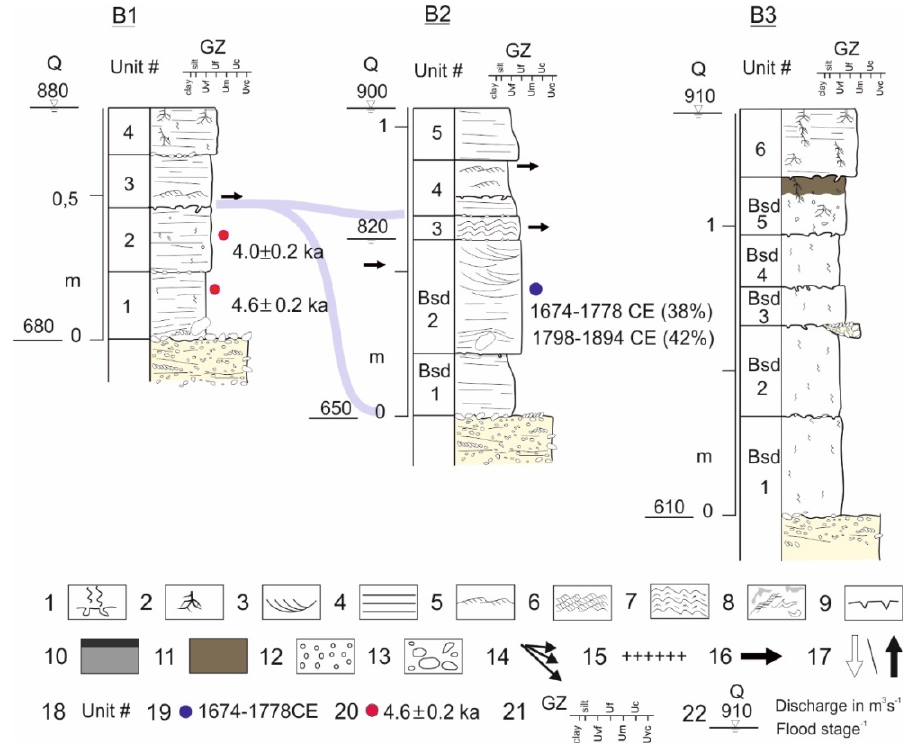
Figure 4. Stratigraphic profiles B1, B2 and B3 and proposed correlations. Radiocarbon dates in